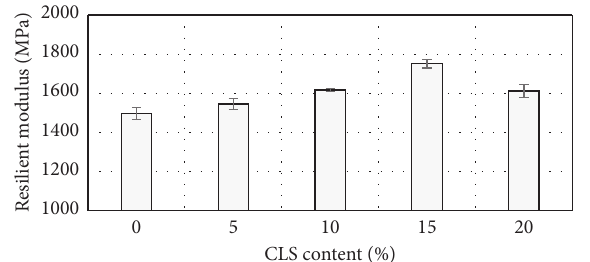
Figure 7: Resilient modulus of asphalt mixtures.